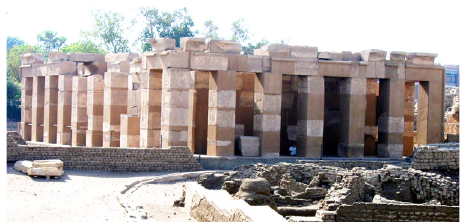
Fig. 6: New Kingdom temple of the goddess Satet on Elephantine island. Reconstruc- tion by the German Archaeological Insti- tute. (Photo: R.